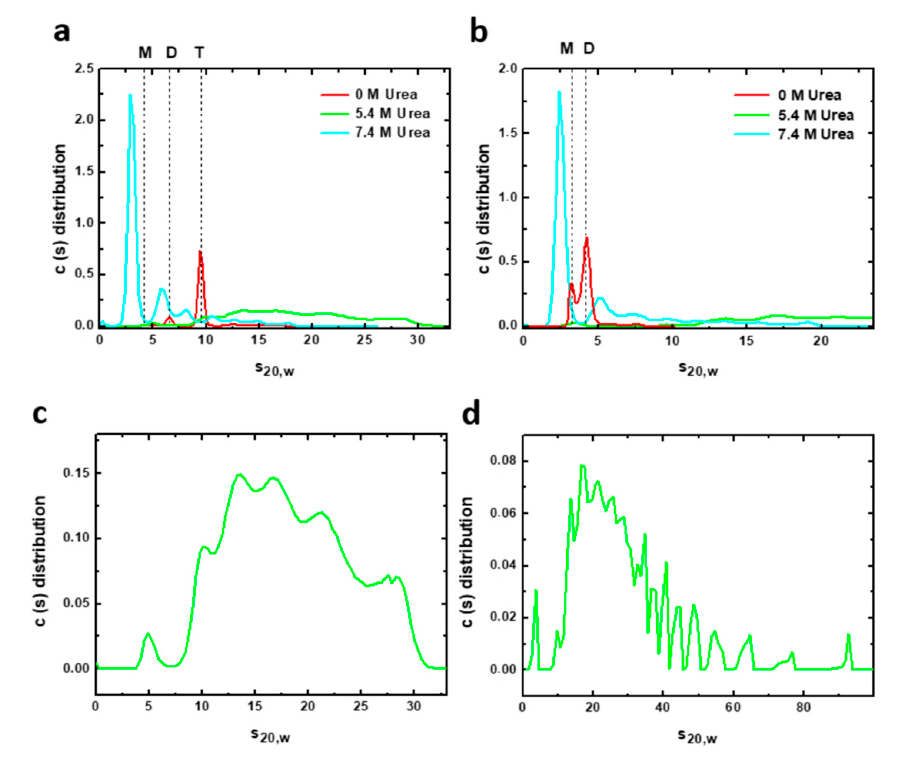
Figure 5. Velocity sedimentation (AUC) assays of human PAH in native and chemical denaturing conditions. Sedimentation profiles of ( a ) 8 µM PAHt and ( b ) 8 µM PAHd incubated at different urea concentrations: 0, 5.4 and 7.4 M. The solid lines represent the size distribution of sedimenting species obtained by c(s) analysis. Vertical discontinuous lines indicate the normalized sedimentation coefficients in water at 20 °C of different oligomeric PAH forms: tetramer (T), dimer (D) and monomer (M) in native conditions. Bottom panels are the sedimentation profiles of ( c ) 8 µM PAHt and ( d ) 8 µM PAHd incubated at 5.4 M urea obtained by c(s) analysis. PAH samples at this urea concentration are characterized by a great polidispersity with multiple species of fast sedimentation.